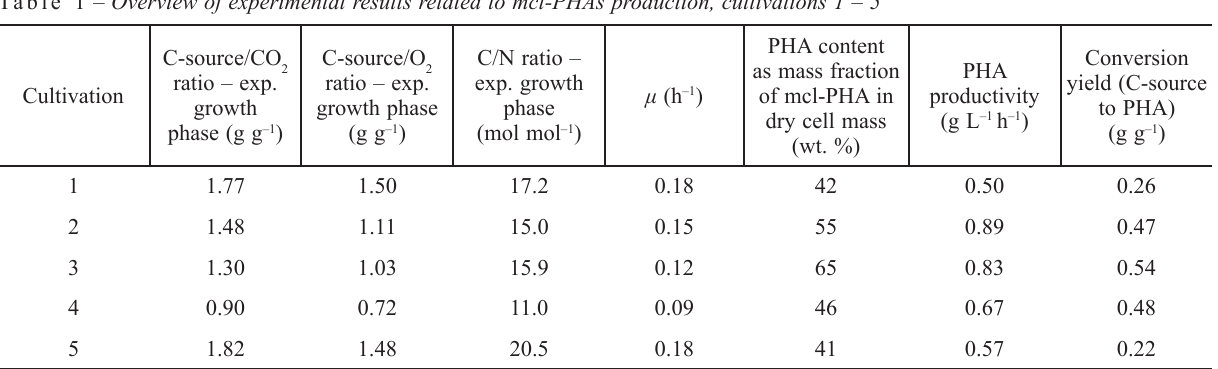
Table 1 – Overview of experimental results related to mcl-PHAs production, cultivations 1 – 5